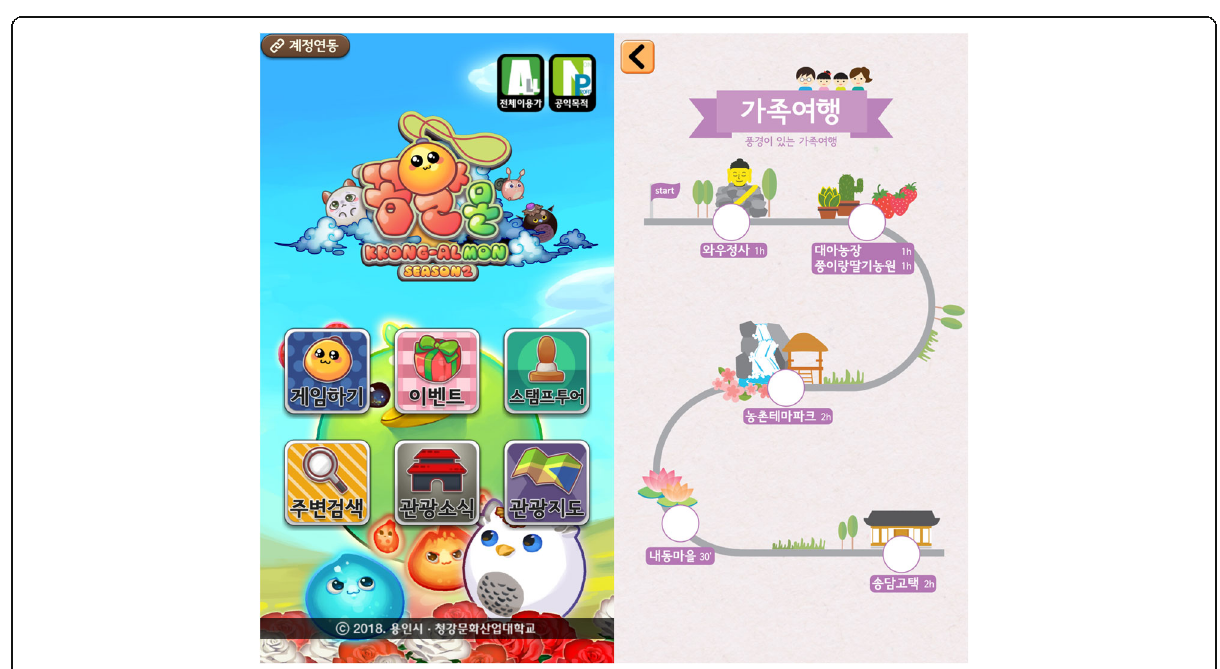
Fig. 4 Kkongalmon. An example image of a Kkongalmon game